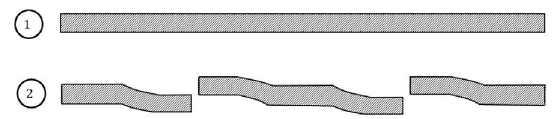
Figure 1. Representation of a typical geometry obtained with the process of cutting the plate and bending the